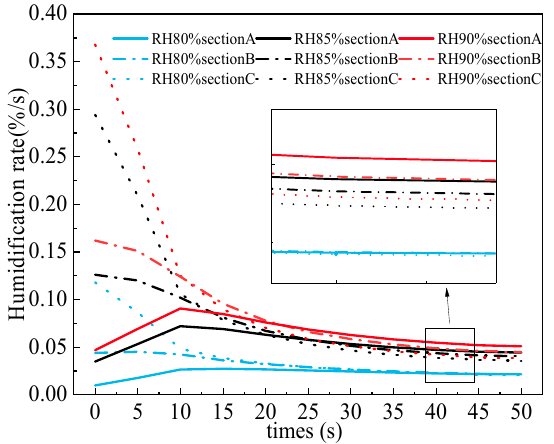
Figure 8. The effect of different relative humidity levels on humidification